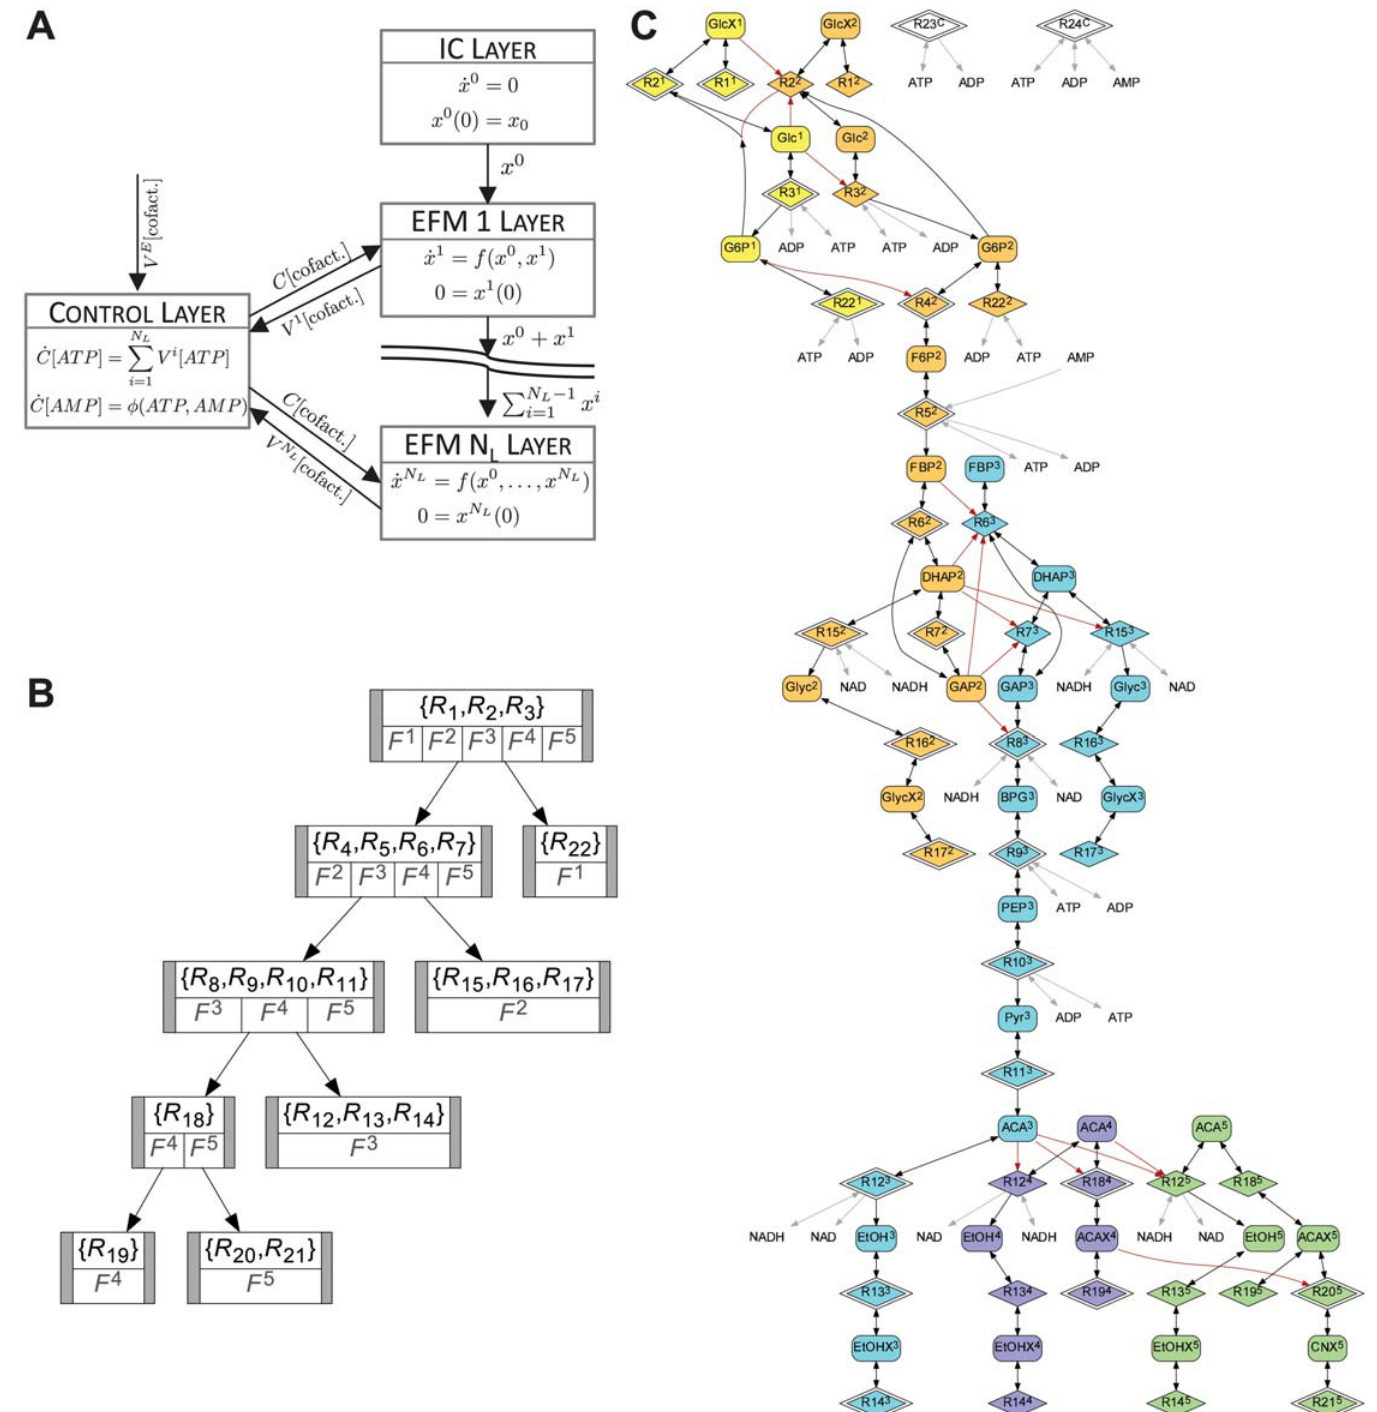
Fig 10. Layering of the glycolytic pathway. A) Mixed layer structure (simplified). Each EFM corresponds to a functionality in the cascaded layer structure. The control layer communicates with all other layers by sending to each the current cofactor concentrations C [cofact.], and by receiving the cofactor production/consumption rate V i [cofact.], i 2 1, ... , N L , of each EFM, but also of other cellular processes ( V E [cofact.]). B) Graph representing the common reactions of the EFMs. Each note represents a set of reactions shared by the indicated EFMs. The binary tree structure of this graph is a special property of the glycolytic model [48]. C) Species-reaction graph (compare [18]) representing the models of the cascaded layers as well as the inter-layer information transfer. Rounded rectangles represent metabolite concentrations, diamonds reactions. An arrow is drawn from a metabolite to a reaction if the reaction rate